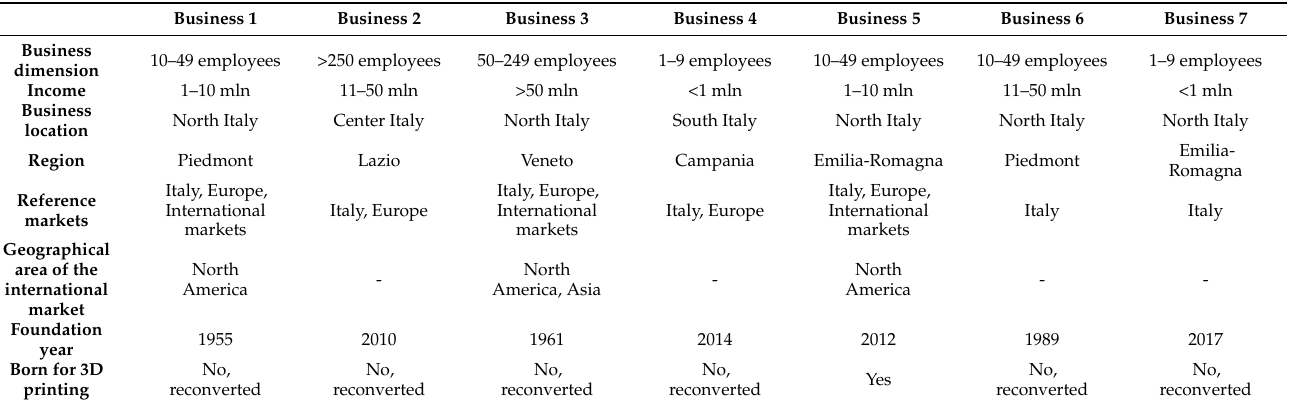
Table 1. Socio-demographic profile of companies.